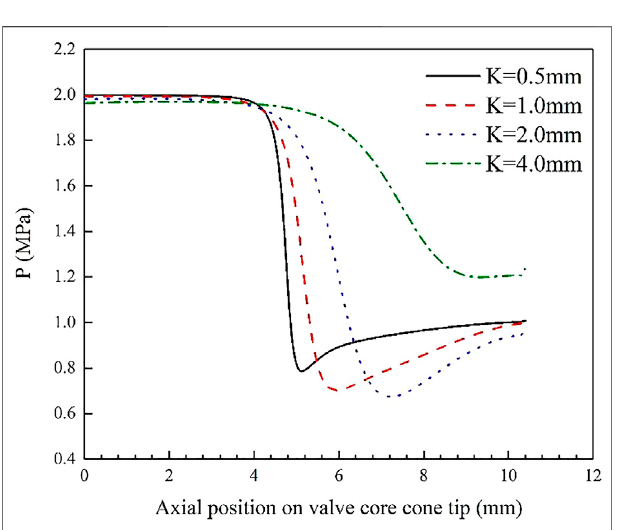
FIGURE 12 | Pressure distribution along the outline of the valve core tip at different openings.